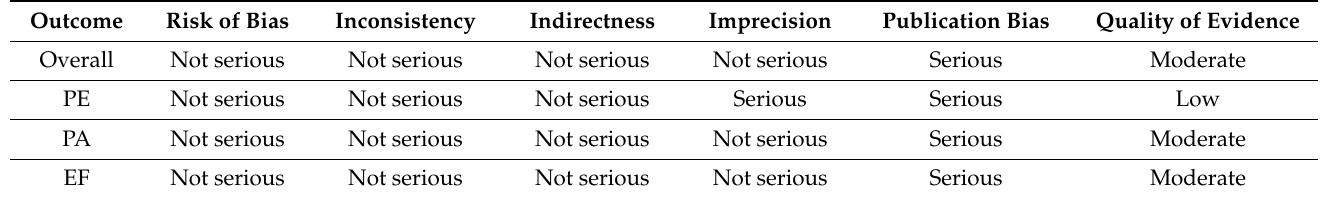
Table 3. Quality of evidence based on the GRADE